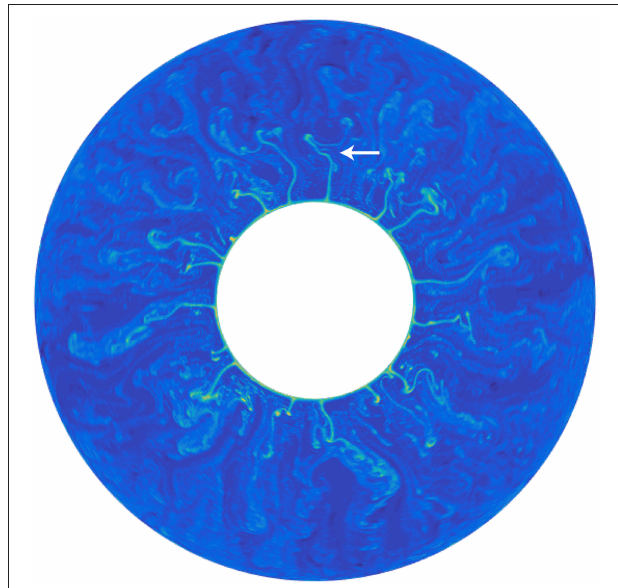
FIGURE 8 | Equatorial snapshot of the compositional field for case 9 ∗ .